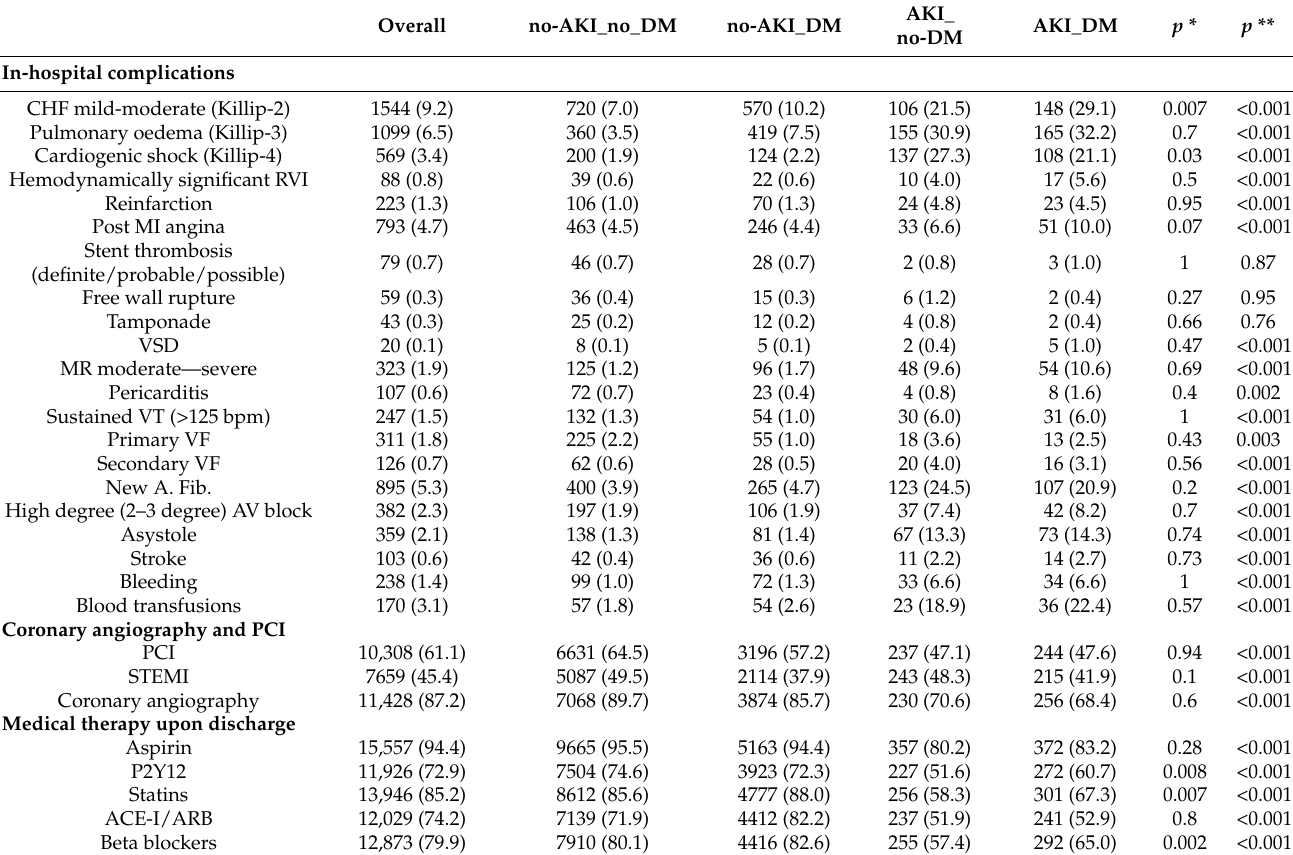
Table 2. In hospital complications, reperfusion therapy and treatment upon discharge by DM status and